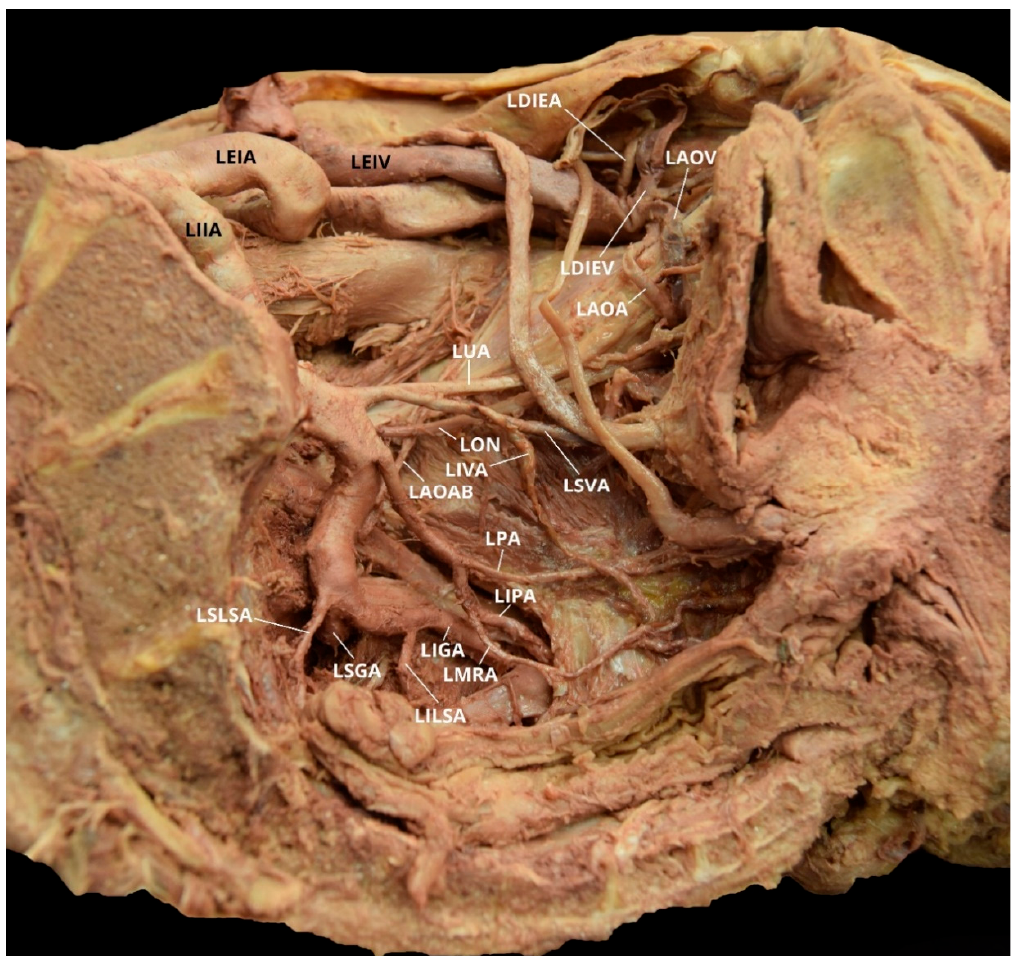
Figure 2. Facilitated display highlighting the left internal iliac artery branches with the left aberrant obturator artery for Case 1. LAOA = Left Aberrant Obturator Artery; LAOAB = Left Accessory Obturator Artery Branch; LAOV = Left Aberrant Obturator Vein; LDIEA = Left Deep Inferior Epigastric Artery; LDIEV = Left Deep Inferior Epigastric Vein; LEIA = Left External Iliac Artery; LEIV = Left External Iliac Vein; LIGA = Left Inferior Gluteal Artery; LIIA = Left Internal Iliac Artery; LILSA = Left Inferior Lateral Sacral Artery; LIPA = Left Internal Pudendal Artery; LIVA = Left Inferior Vesical Artery; LMRA = Left Middle Rectal Artery; LON = Left Obturator Nerve; LPA = Left Prostatic Artery; LSGA = Left Superior Gluteal Artery; LSLSA = Left Superior Lateral Sacral Artery; LSVA = Left Superior Vesical Artery; LUA = Left Umbilical Artery. The Left Iliolumbar Artery (LILA) is not pictured.